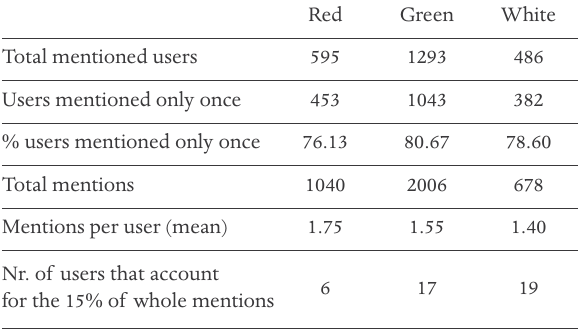
Table 5. User mentions and retweet in the three zones of Figure